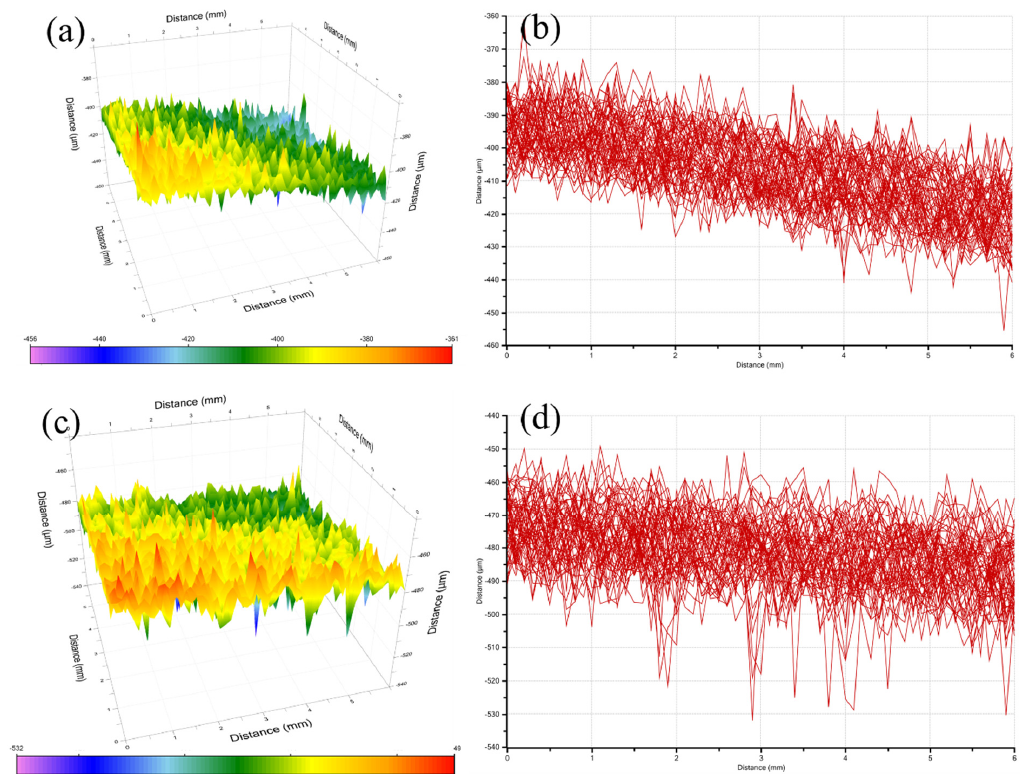
Figure 5. Corrosion depth of Diamond / Cu composites after salt spray corrosion for 168 h: ( a ) 3D topography of 60 vol% Diamond / Cu composites; ( b ) corrosion interval depth of 60 vol% Diamond / Cu composites; ( c ) 3D topography of 75 vol% Diamond / Cu composites; ( d ) corrosion interval depth of 75 vol% Diamond/Cu composites.